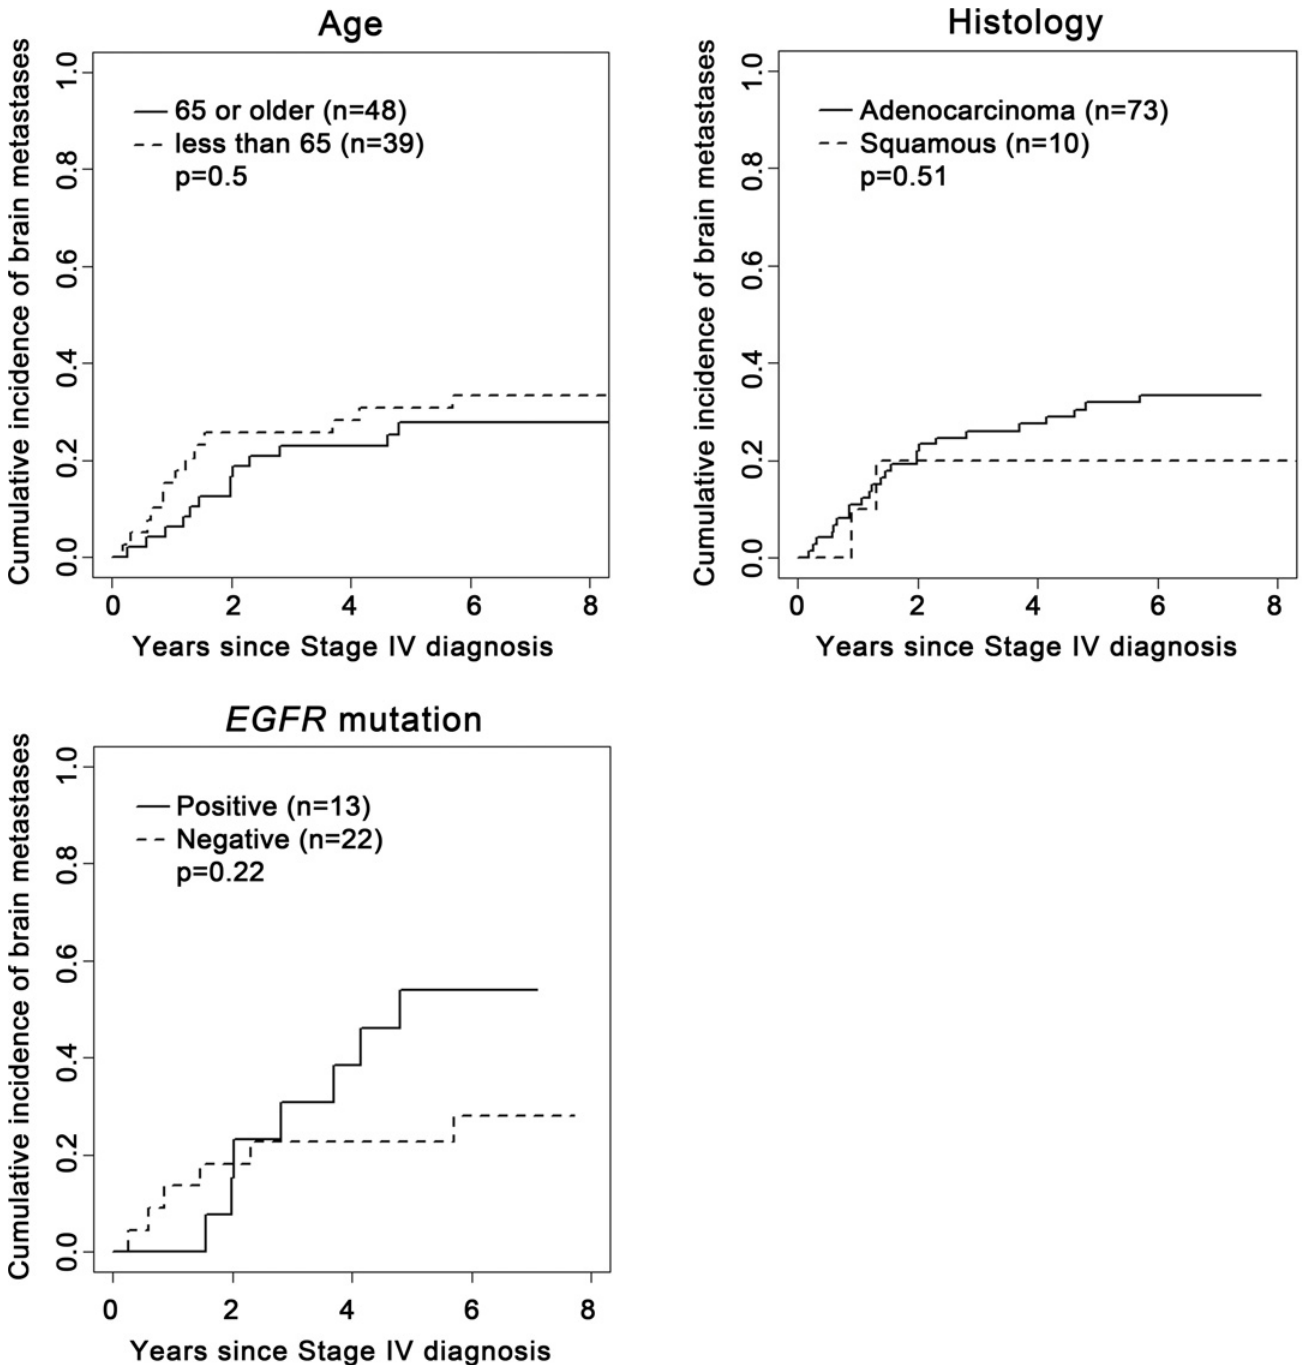
Fig 2. Association of clinical factors with cumulative incidence of subsequent brain metastasis in patients who did not experience brain metastasis at baseline.